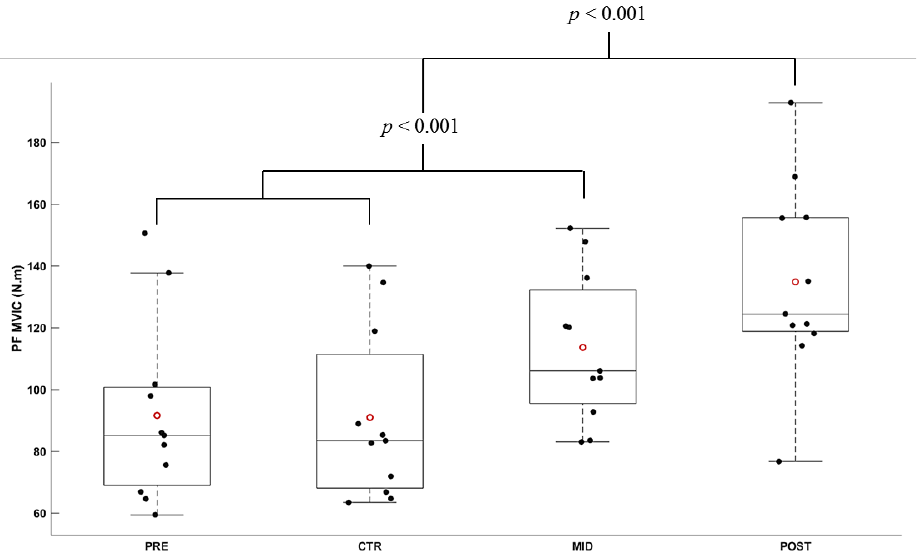
Figure 3. Average torque during MVIC in plantarflexion (N.m) according to the evaluation session (PRE, CTR, MID, POST sessions). Each whiskers box indicates the mean (red circle) and the median (horizontal line). The inferior edge and superior edges of the box indicate the 25th and 75th percentile, respectively. Error bars represent the most extreme and non-outlier data points. Black dots represent individual participant performance.